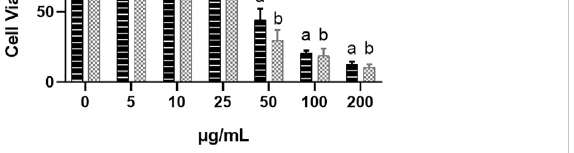
FIGURE 9 Cytotoxicity of Lceo-AgNPs and AgNPs in macrophages. 0 μ g/ml as control group and the data were analyzed using t -test to determine signi fi cance of difference. a: signi fi cant difference when the Lceo-AgNPs-treated group were compared to control group; b: signi fi cant difference when the AgNPs-treated group were compared to the control group.